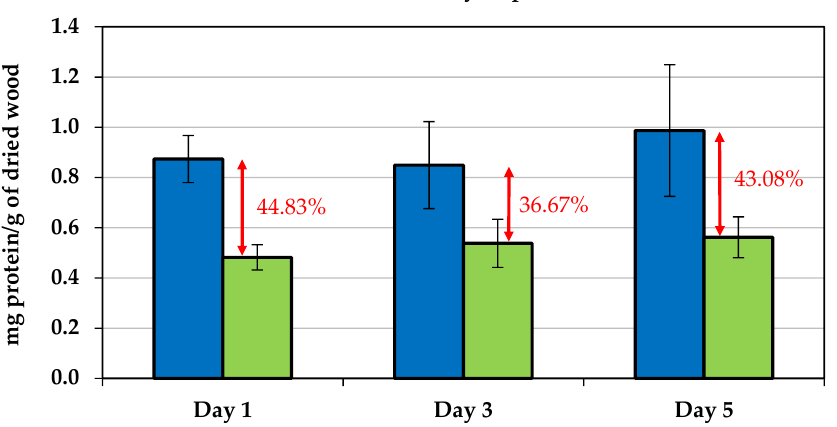
Figure 5. Protein measurement of the hydrophobized pine veneers submerged for 5 days in a marine broth containing a C. marina culture.